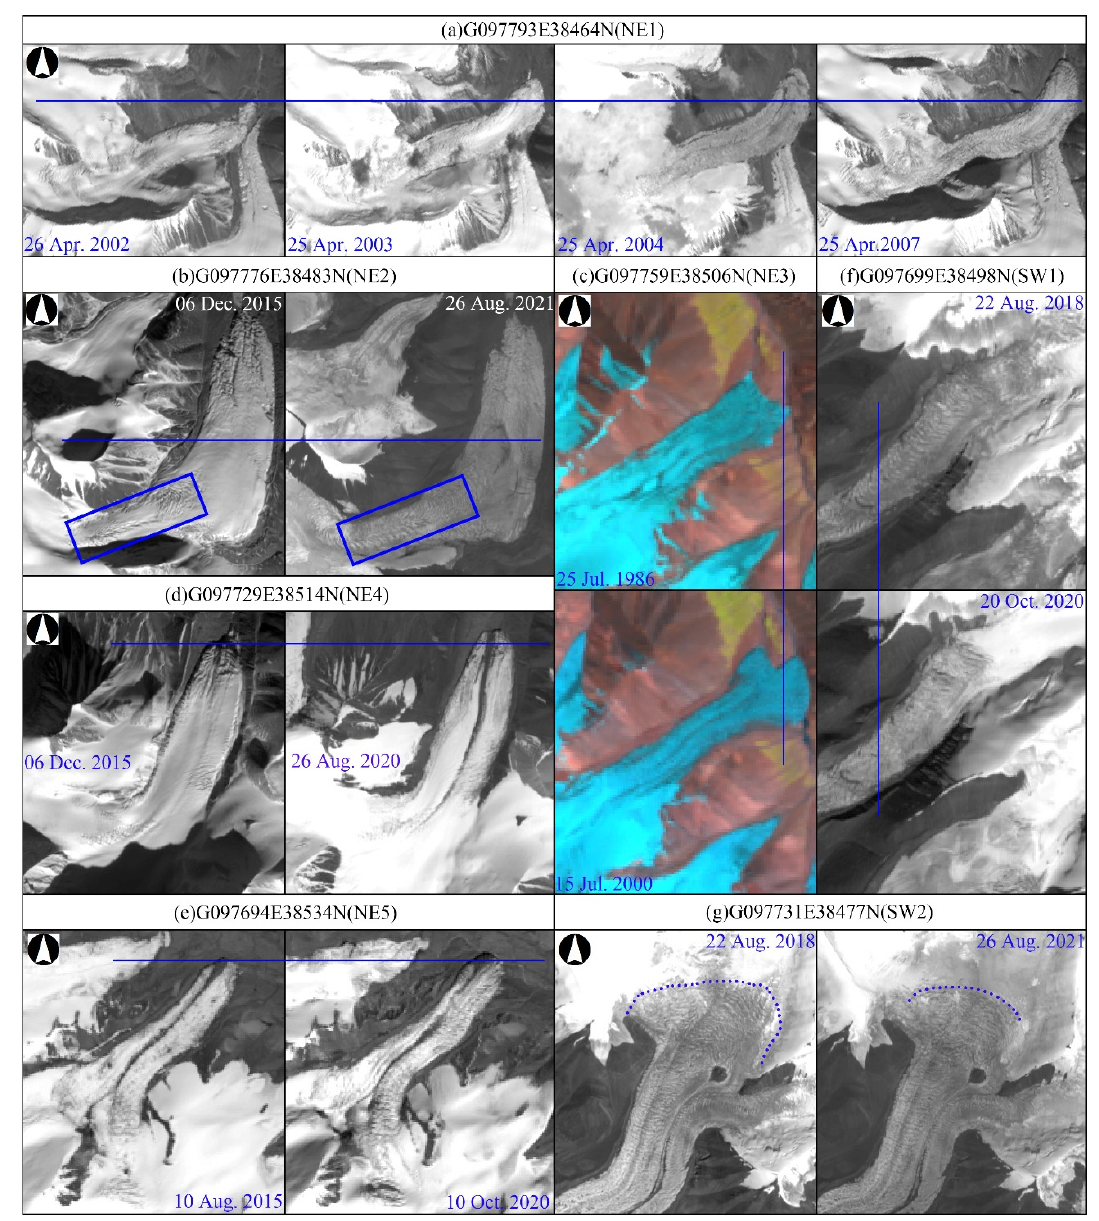
Figure 4. The dynamic evolution of glacier surface morphology at the active phase in the TJP region, including rapid advance of the frontal position, obvious feature of glacier surface, and heavy surface crevassing. The results are derived from Landsat TM, Sentinel-2, and ASTER, whose spatial resolution is 30 m, 10 m, and 15 m, respectively. NE1 panels show the visible and near-infrared (VNIR) band of ASTER. NE3 and SW2 panels show the near-infrared (NIR) band of Landsat TM, while the others show Sentinel-2.